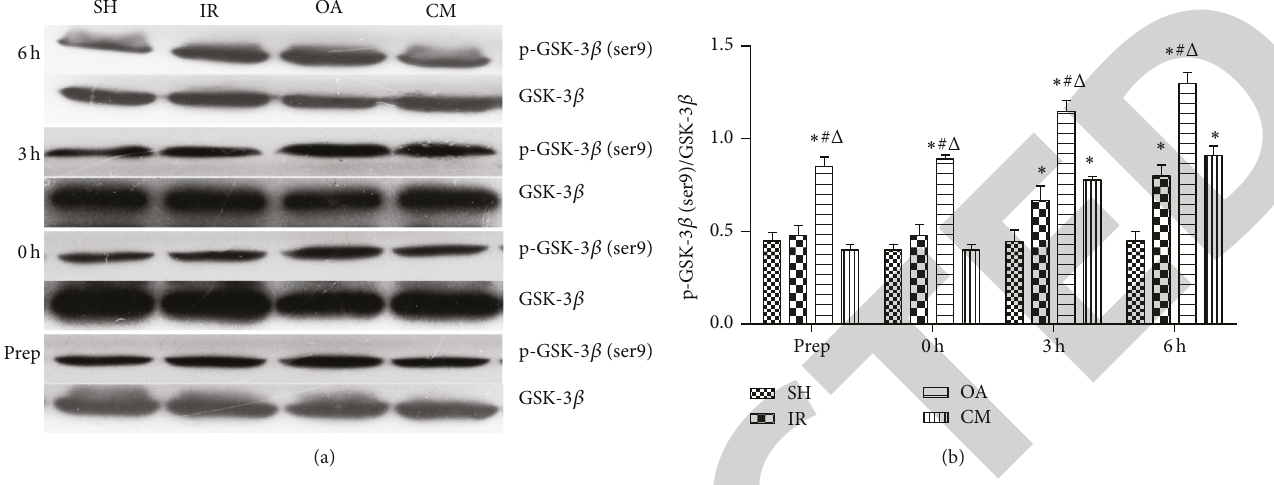
Figure 6: Effects of pretreatment with OA on p-GSK-3 𝛽 (ser9) and GSK-3 𝛽 protein expression in rats induced by partial hepatic ischemia- reperfusion (IR). Expression of p-GSK-3 𝛽 (ser9) and GSK-3 𝛽 protein was detected by western blot analysis (a). These bands were quantified and analyzed (b). Data are represented as mean ± SD ( 𝑛 = 8 ). ∗ 𝑃 < 0.05 , compared with group SH. # 𝑃 < 0.05 , compared with group IR. Δ 𝑃 < 0.05 , compared with group